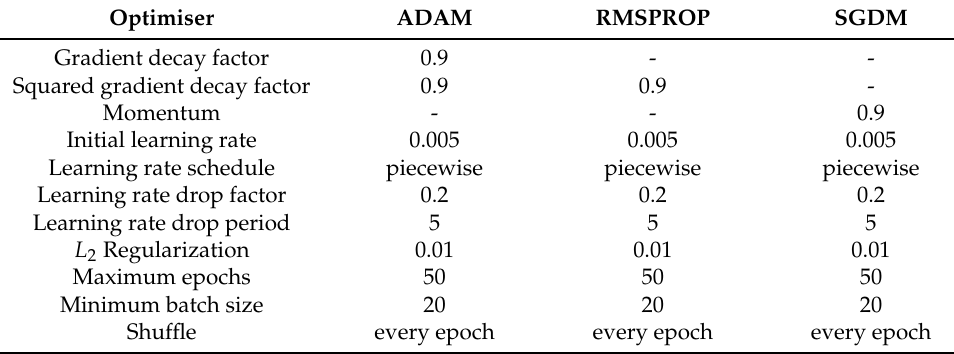
Table 7. The model hyperparameters for both the ULSTM and BLSTM neural networks with three